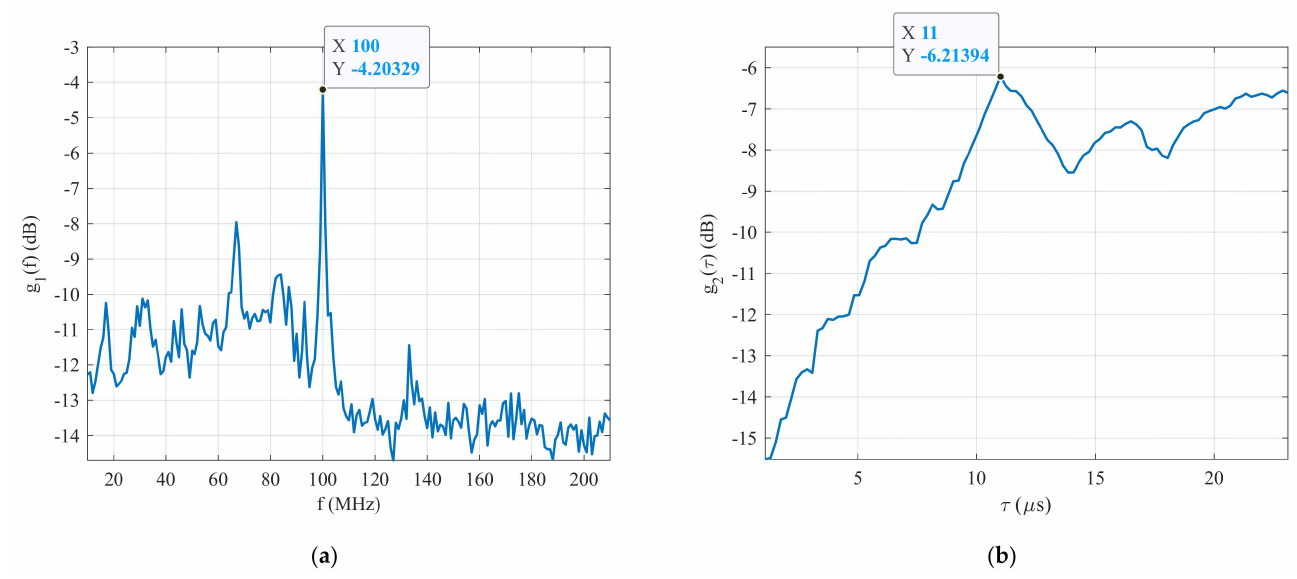
Figure 12. The simulation results: ( a ) detection process, and ( b ) pulse width estimation.